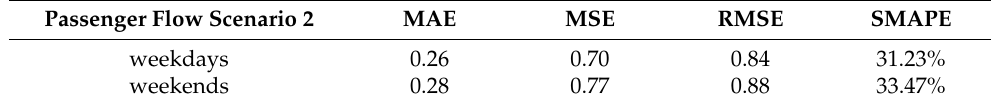
Table 10. The metrics of forecasting results for residential areas to CBD OD flow.